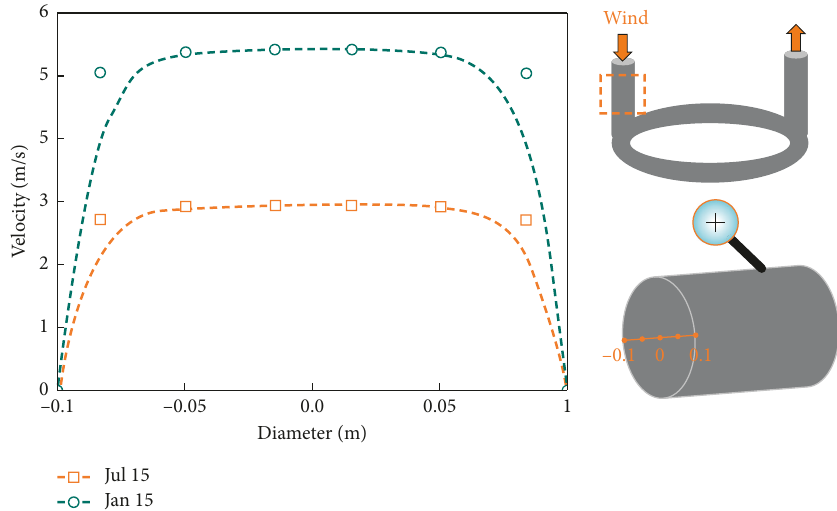
Figure 2: Radial wind velocity distribution inside the duct on January 15 and July 15.